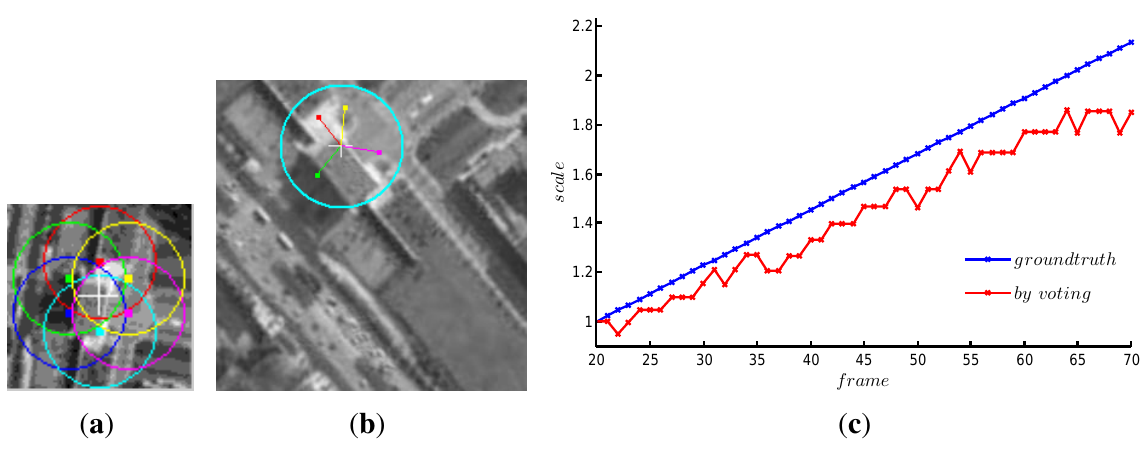
Figure 8. Test results without the subtemplates selection strategy. ( a ) evenly distributed subtemplates; ( b ) tracking results of frame #70 ; ( c ) determined scale factors comparing to the ground